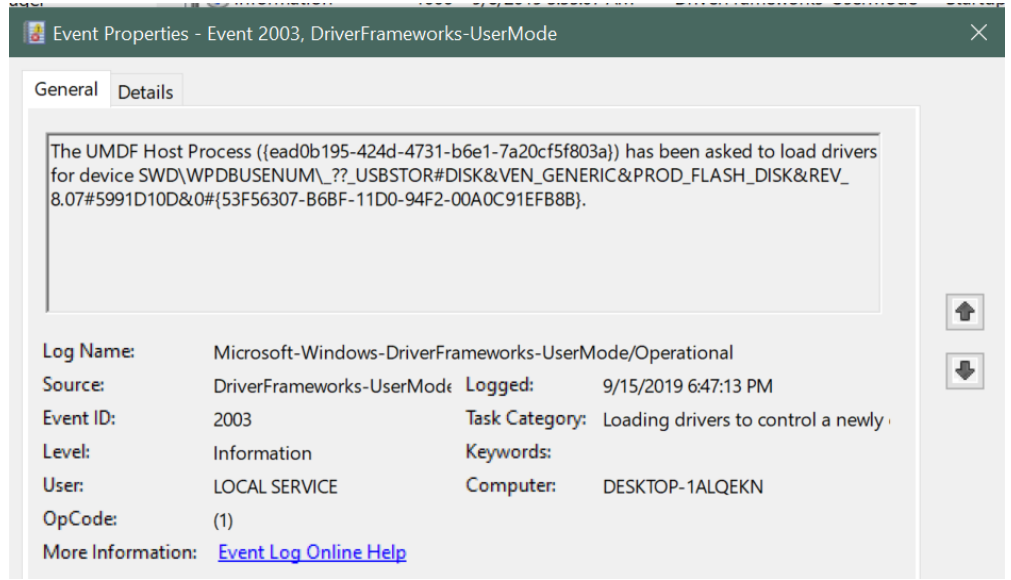
Figure 5. Event ID 2003 for generic USB drive.